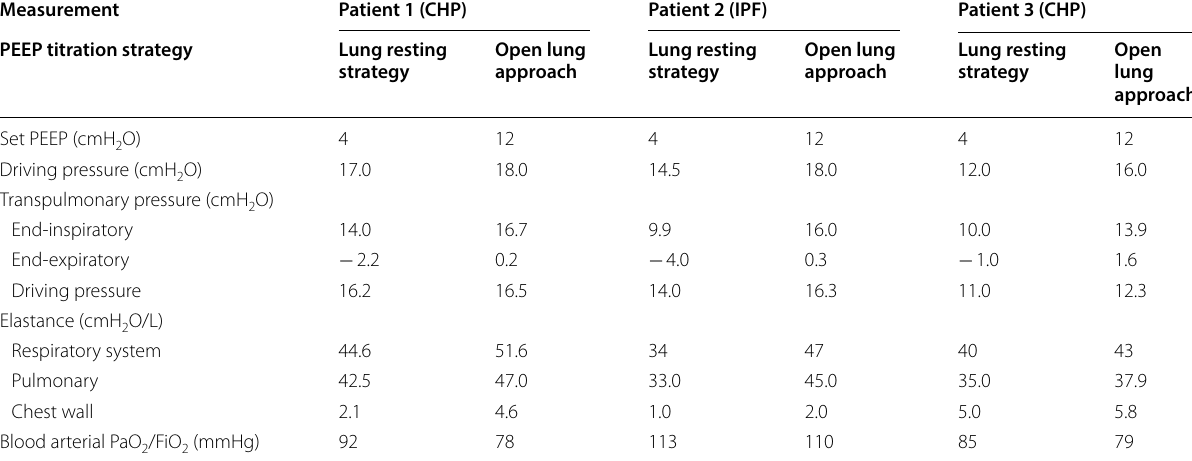
Table 1 Lung mechanical properties of three patients experiencing acute exacerbation of interstitial lung disease